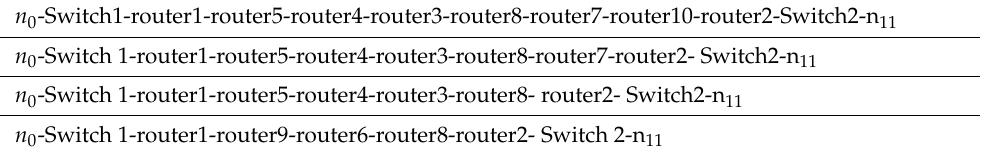
Table 3. Set of 118 possible routes between the attack node ( n 0 ) and the victim ( n 11 ).